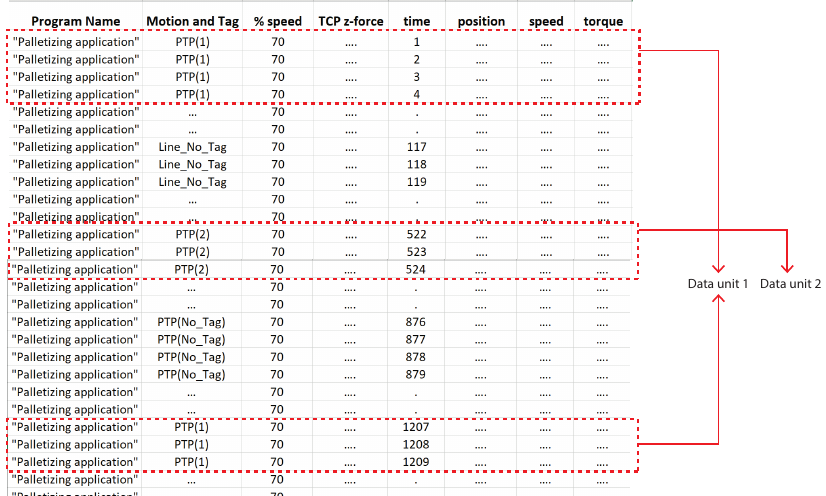
Figure 11. Image representing the data unit extraction applied during the execution of the palletiz- ing